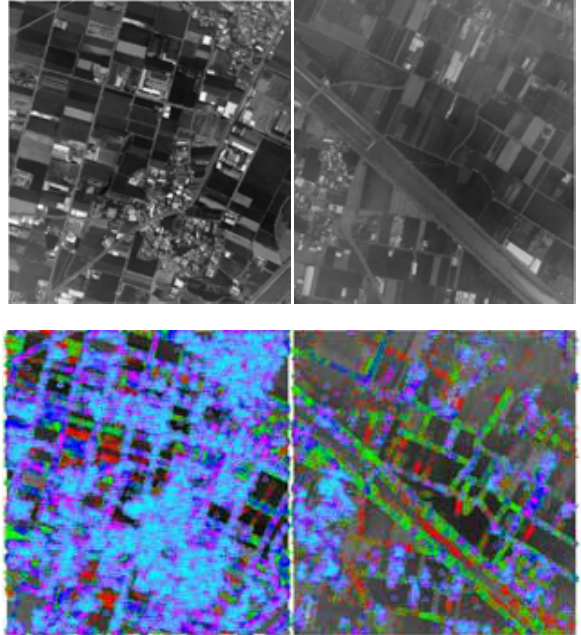
Figure 9. Extracted key points (bottom) from two original images (top) 10123 (left) and 60185 (right)